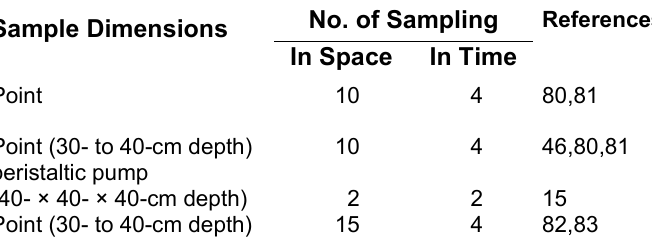
List of the Elements Evaluated in the Interstitial Environment in the Stretches 8, 9,